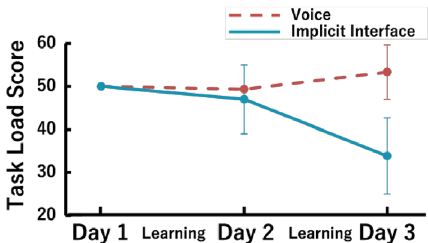
Fig. 17 Cognitive load evaluation